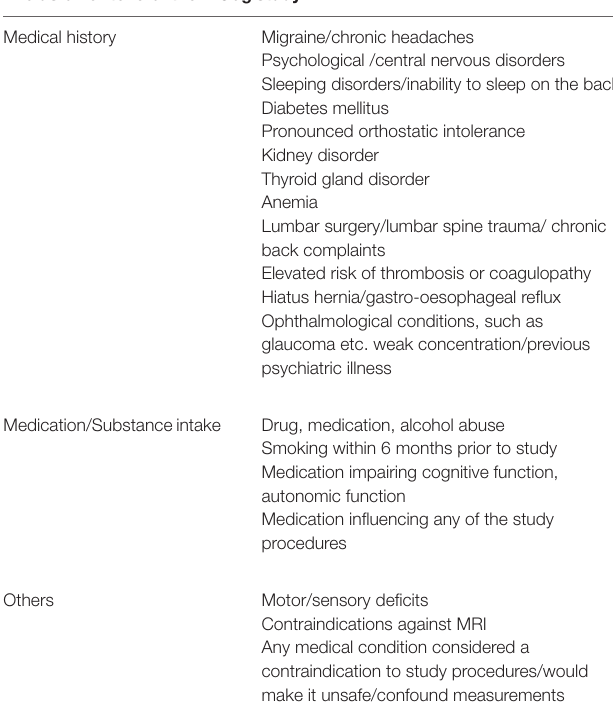
TABLE 1 | Exclusion criteria.